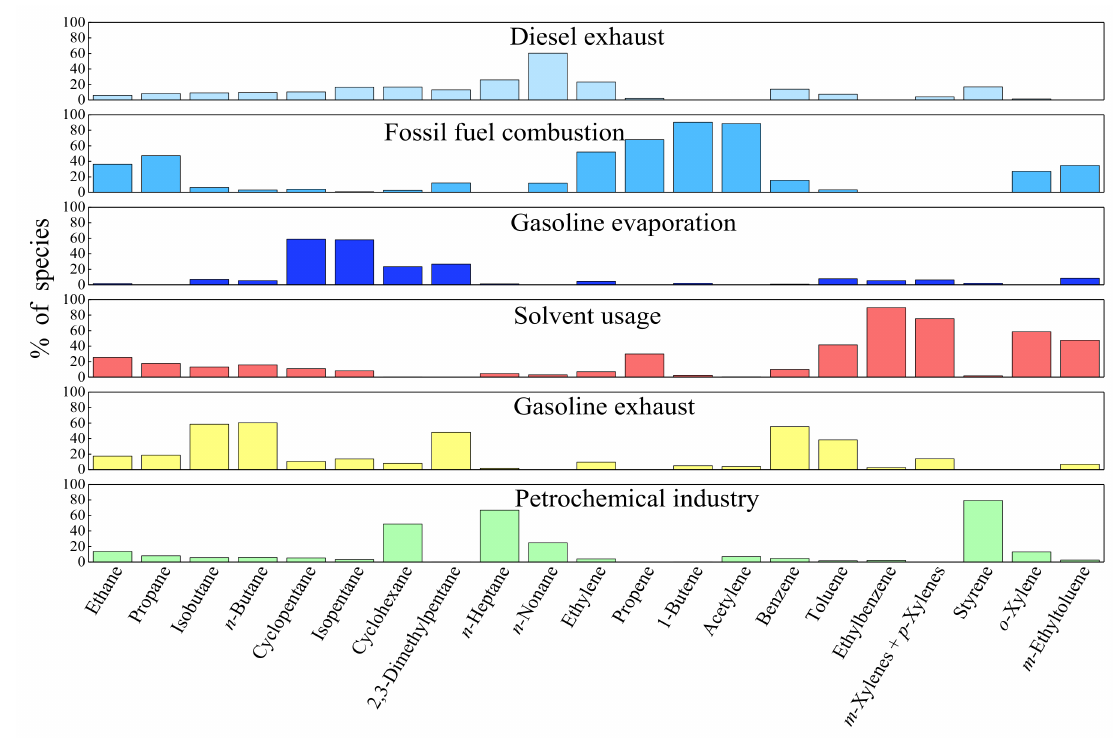
Figure 3. Factor profiles (% of species) of each source during the whole observation period.